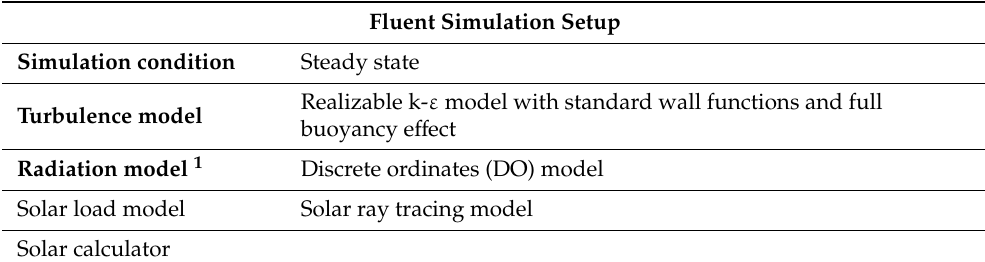
Table 2. Fluent simulation